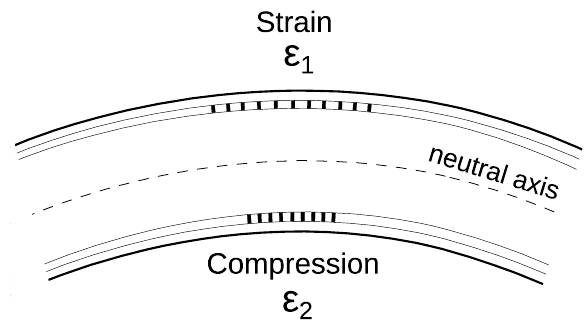
Figure 1. The principle of the differential scheme operation for deformation measuring.